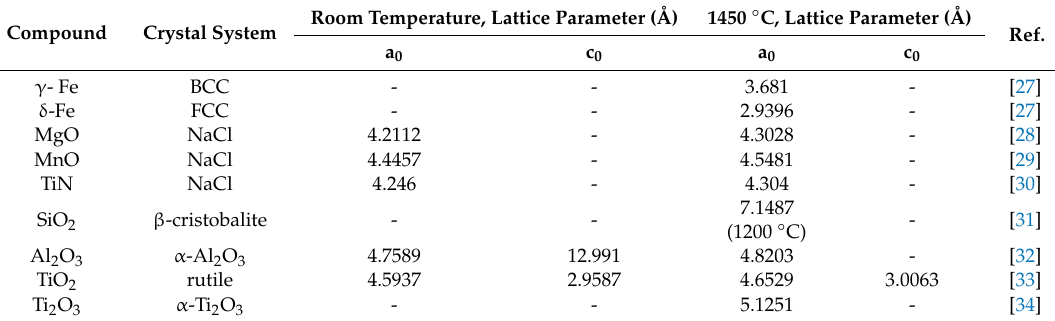
Table 3. Crystallographic data for the e ff ective nucleating agent and matrix metal.